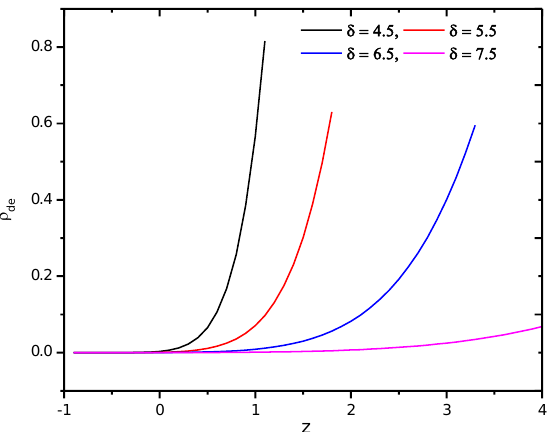
Figure 3. Behavior of Tsallis holographic dark energy density of f ( T , B ) gravity model in Hubble’s horizon cutoff versus redshift for the appropriate choice of constants = 0.1 and β =